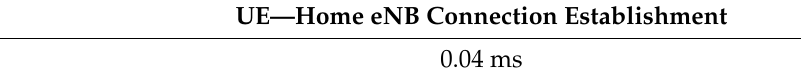
Table 1. Normal Connection Time Performance.